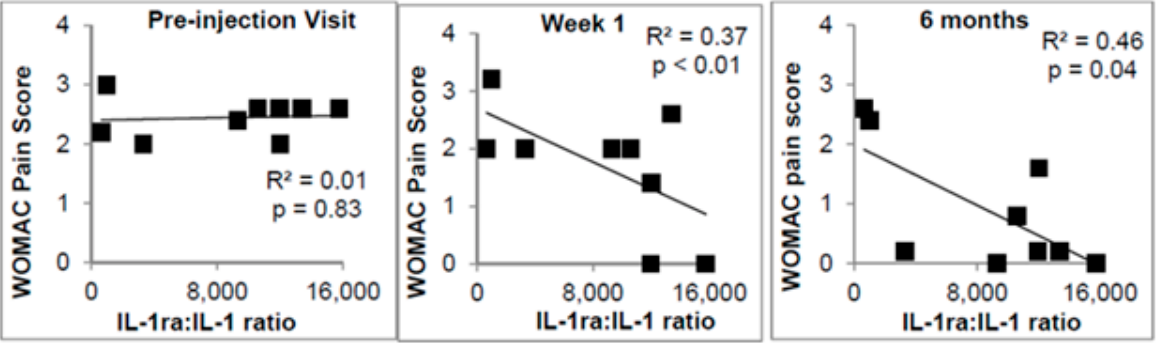
Figure 3. Correlation of WOMAC pain score and ratio of IL-1ra:IL-1 β injection in OA subjects